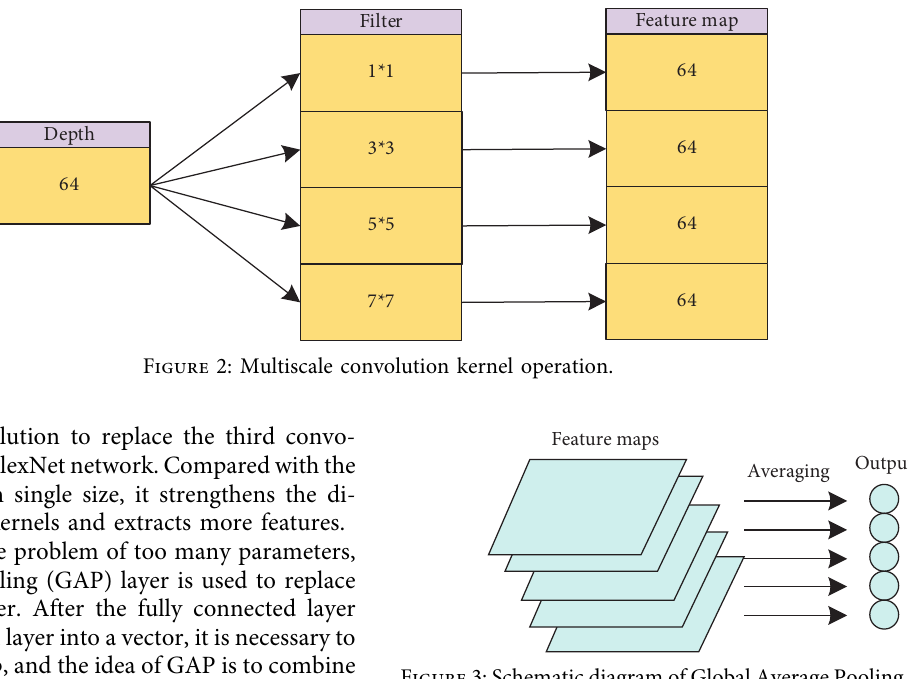
Figure 3: Schematic diagram of Global Average Pooling